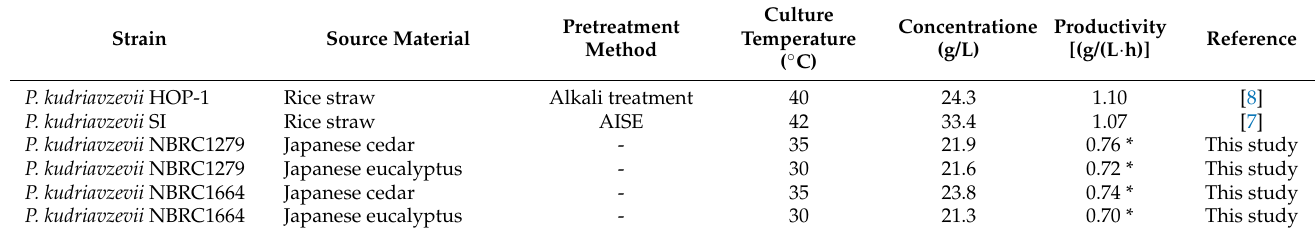
Table 2. Comparison of bioethanol production.